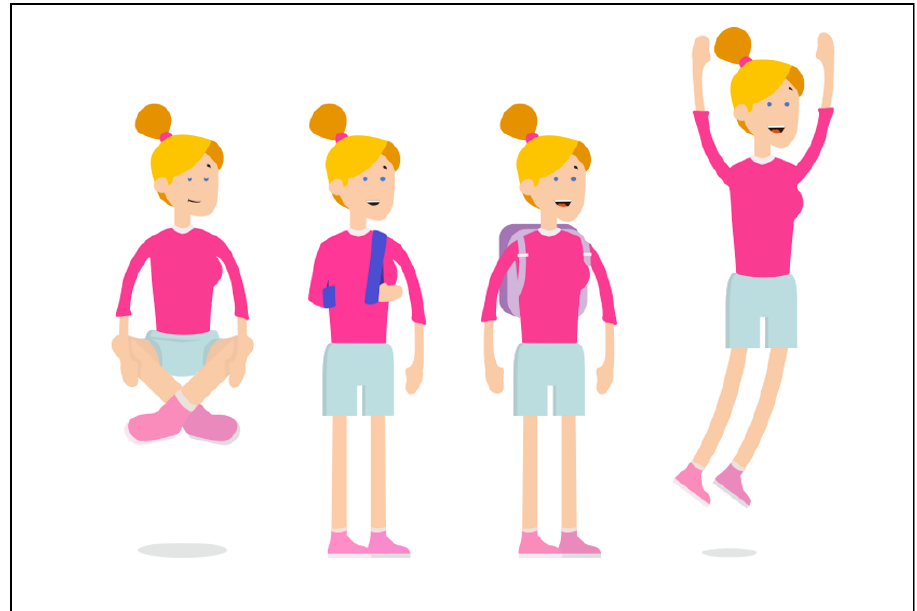
Figure 6. Bright and cheerful avatars on the specific behaviour